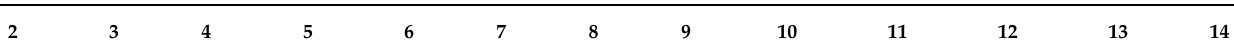
Table 3. Correlations between all study-relevant variables.